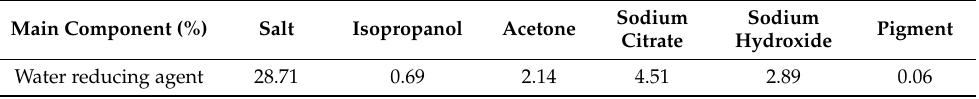
Table 3. The chemical properties of the water reducing agent.